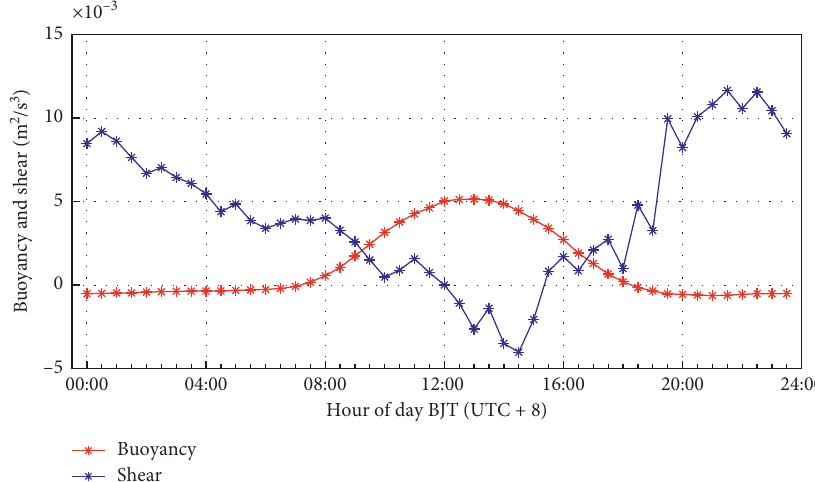
Figure 7: Diurnal variation in the annual averaged turbulence kinetic energy budget.